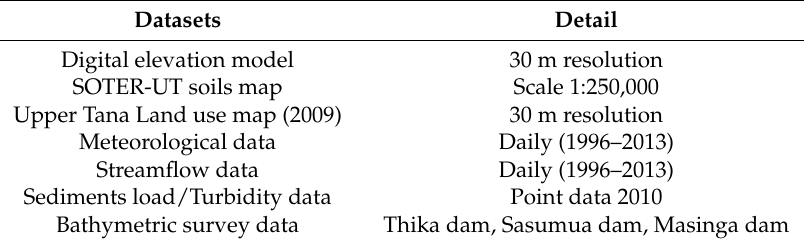
Table 1. Data used in the SWAT model setup.